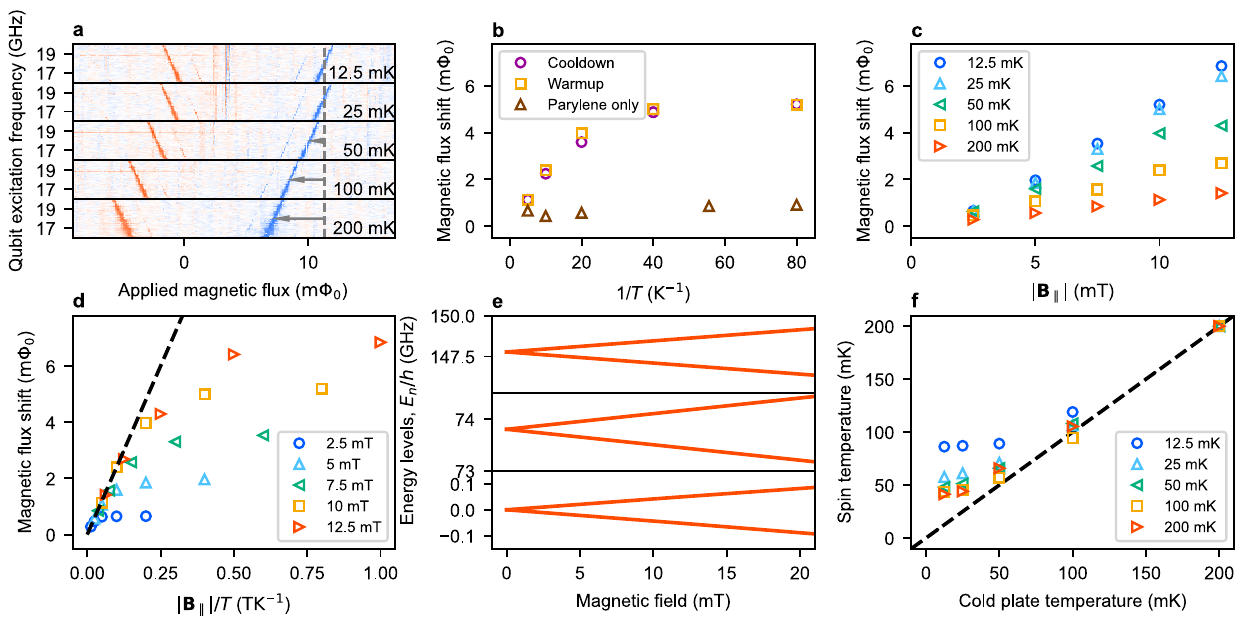
Fig. 2 Results of magnetometry. a Spectra of the fl ux qubit with neurons measured at 12.5, 25, 50, 100, and 200 mK. The temperature was adjusted from low to high in the experiment. The in-plane magnetic fi eld was fi xed at 10 mT. The color scale indicates the switching probability (see Methods) of the SQUID [20% (blue), 50% (white), and 80% (red)]. The switching probability of 50% (20 and 80%) corresponds to the ground (excited) state of the qubit. The arrows referenced to gray dashed line indicate the reduced magnetization induced shifts from the spectra at 12.5 mK. b Temperature dependence of the magnetization with an in-plane magnetic fi eld of 10 mT. The sample was fi rst heated to 200 mK from base temperature (yellow squares). The sample was then cooled from 200 mK to verify the experimental results (purple circles). Magnetization signal of pure parylene-C fi lm is also plotted for comparison (brown triangles). c In-plane magnetic fi eld dependence of the magnetization for different temperatures. d Temperature and in- plane magnetic fi eld dependence of the magnetization as a function of ∣ B ∥ ∣ / T . Original dataset is the same as c . The black dashed line is simulated magnetic fl ux shift. e Calculated energy diagram of electron spins in neurons as a function of magnetic fi eld. Here, h is the Planck ’ s constant. The direction of the magnetic fi eld was + z for this calculation. f Effective spin temperature as a function of the cold plate temperature. The dashed line is a guide for the eye, which indicates that the spin temperature is equal to the cold plate temperature. Error bars (standard error of curve fi tting) in b – d , and f are smaller than the fi lm is laminated as shown in Fig. 1b. The neurons are magne- tized by applying an in-plane magnetic fi eld B ∥ . This magneti- zation shifts the qubit spectrum from the corresponding magnetic fi eld that is experienced by the qubit (Fig. 1c). Thus, magneti-